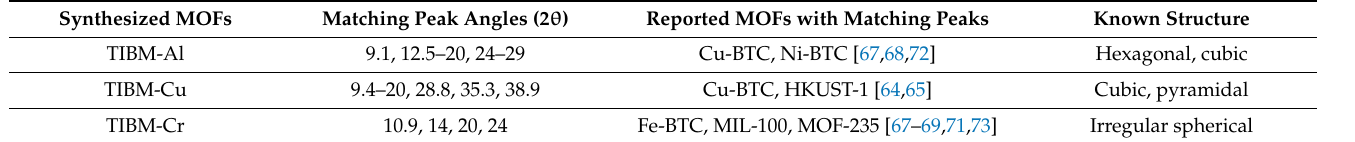
Table 2. Matching the characteristics peaks of TIMB MOFs with reported